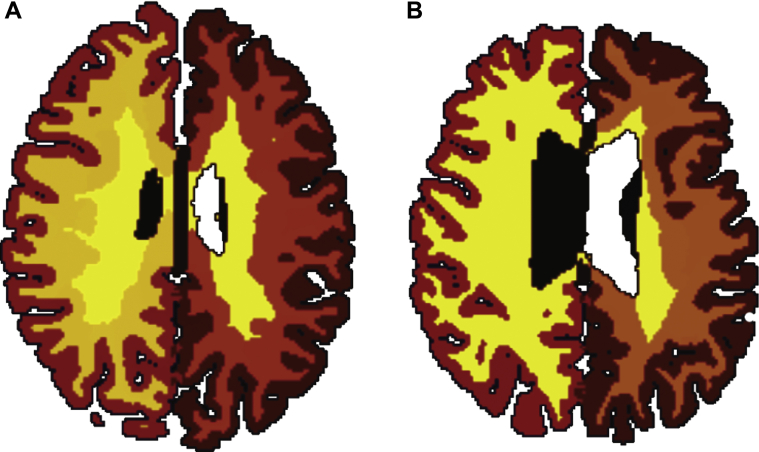
Example of gray and white-matter segmentations in FreeSurfer for, sex-matched subjects (A) lean (56 years, BMI 19.5) and (B) obese (50 years, BMI = 43.4).